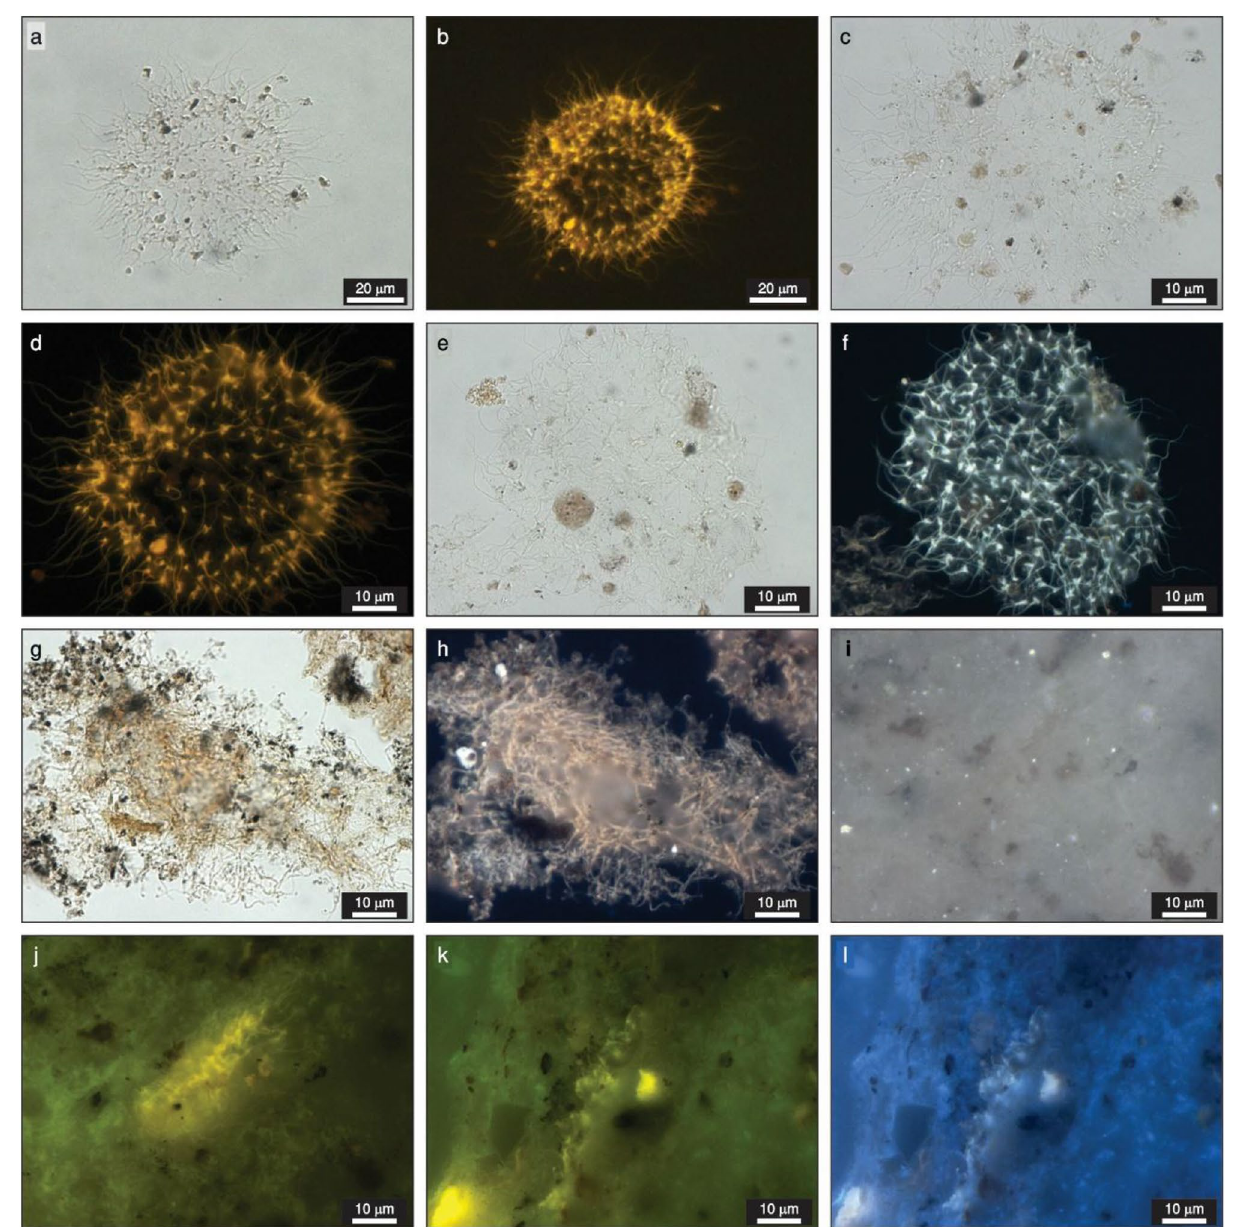
Figure 3. Photomicrographs of choanoflagellates from the Capas Blancas Mb. ( R. cushmani Biozone) at Baños de la Hedionda. ( a , b , c , d ), Choanoflagellate with high preservation state (palynofacies slide). ( e , f , g , h ), Amorphous choanoflagellate (palynofacies slide). ( i , j , k , l ), Choanoflagellate (whole-rock). Transmitted white light: ( a , c , e , g) . Reflected white light: ( i ). Fluorescence mode: ( b , d , f , h , j , k , l